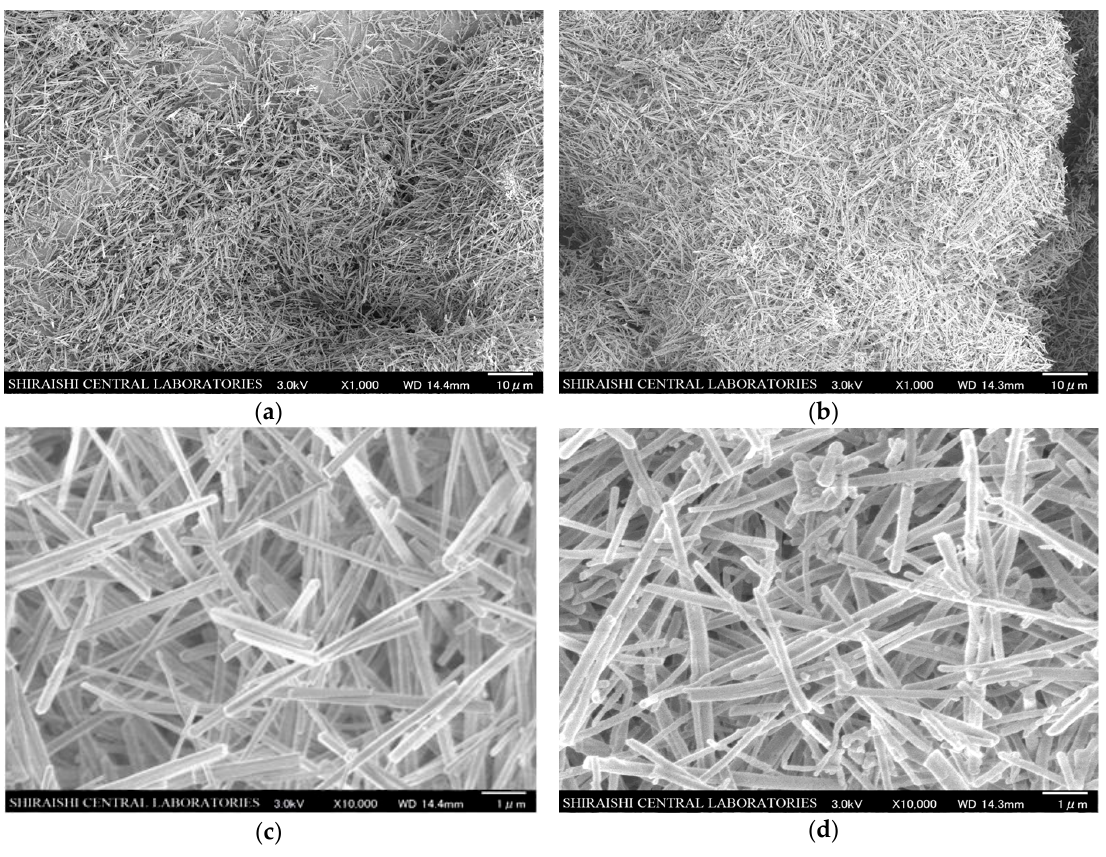
Figure 4. Low- and high-magnification SEM images for aragonite powder ( a , c ) and for calcite powder ( b , d ). Scale-bars are 10 μ m for low-magnification and 1 μ m for high-magnification observations. The needle-like morphology of aragonite particles was maintained even after the heat treatment, to form calcite needle-like particles.